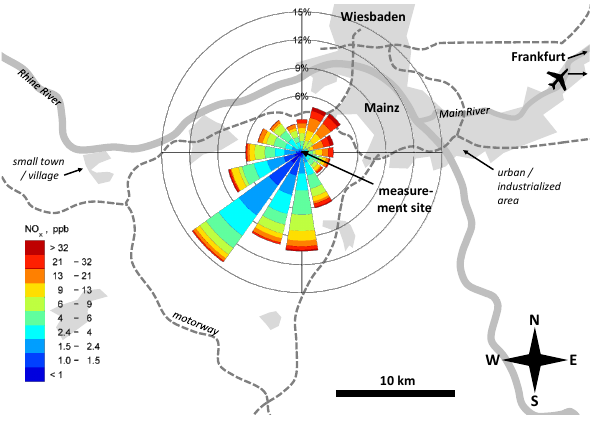
Figure 1. Location of the Mainz Finthen grassland site located at the edge of the industrialized Rhine-Main area in Germany. The wind rose, centred at the measurement site, indicates unpolluted (low NO x ) air masses from the south west sector and more polluted (high NO x ) air masses from north easterly